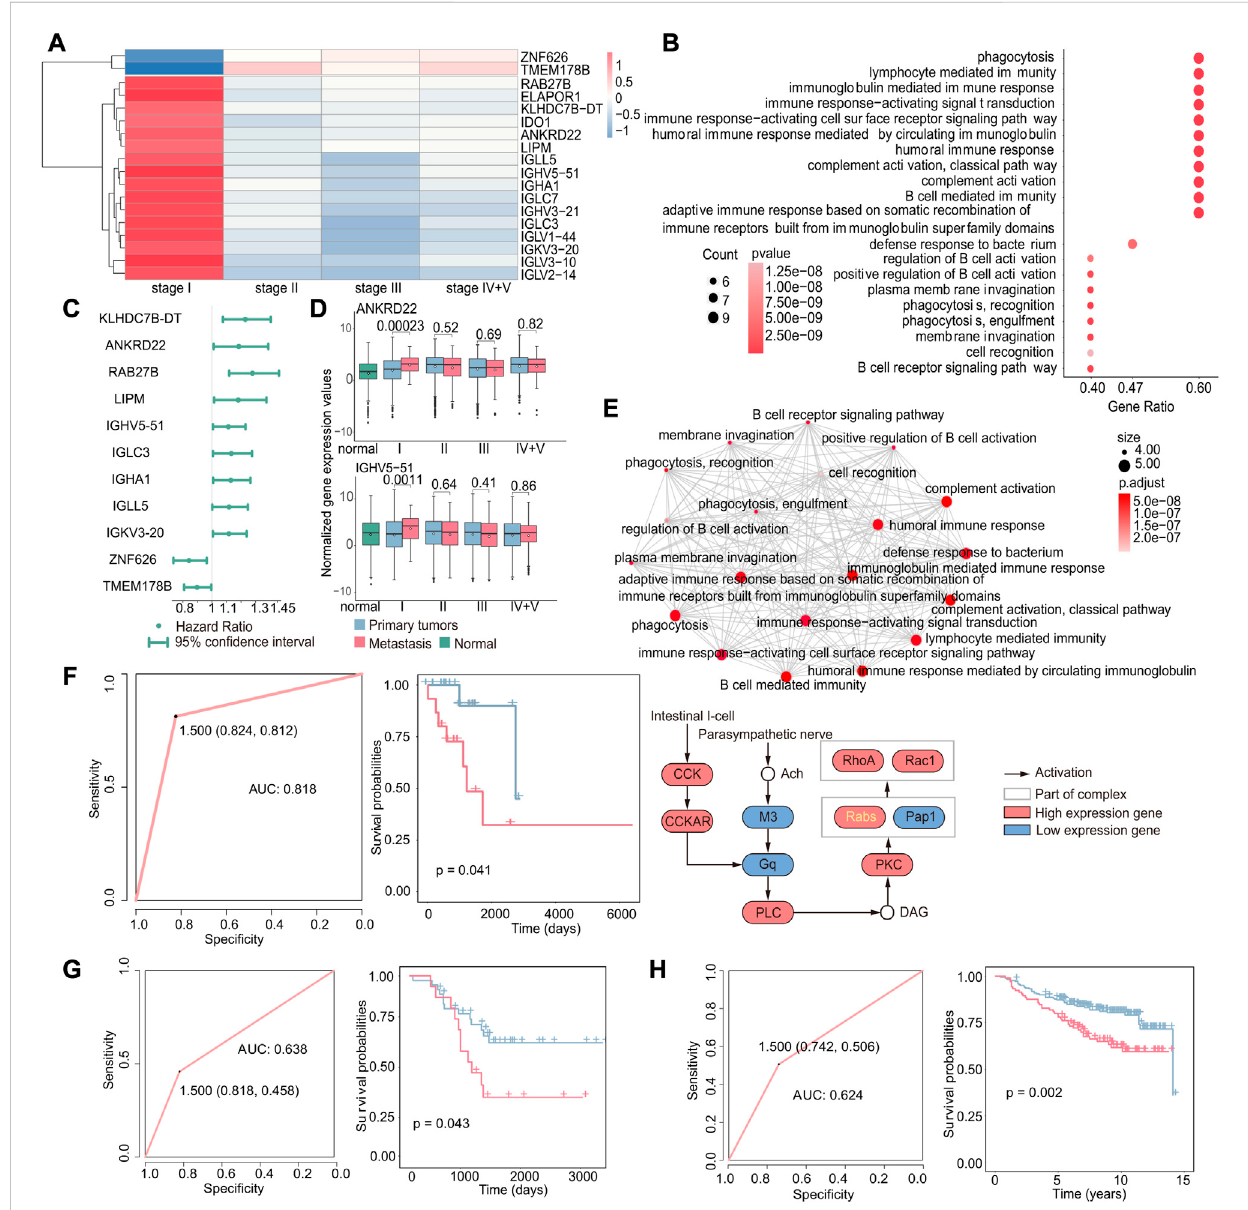
FIGURE 5 Gene expression-based biomarkers related to early metastasis. (A) Heatmap of speci fi c differentially expressed genes in stage I. Red indicates that gene expression was upregulated in metastatic tumors, while blue indicates downregulation. (B) GO enrichment analysis of speci fi c differentially expressed genes in stage I. The size of the dot indicates the number of genes involved in the pathway, and the color of the dot indicates the p -value. (C) Cox regression analysis of stage I-speci fi c differentially expressed genes related to prognosis. The point is the value of the hazard ratio, and a value greater than 1indicates that it wasrelated to poor prognosis. (D) Boxplot oftheexpression ofANKRD22and IGHV5-51 innormal, primary, and metastatic tumor samples. (E) GO enrichmentanalysisof nine genes that wererelated to poor prognosis and speci fi cally differentially expressedin stage I(up). Each dot represents a pathway, and the connecting two points mean that the same genes were in the pathways; KEGG enrichment analysis of the nine genes (down). Speci fi c genes in the KEGG pathway were marked in yellow. (F) Based on these nine genes, the ROC curve of the classi fi er constructed by the supportvectormachinemethodandtheKaplan – Meiersurvivalcurveoftheresultoftheclassi fi er.Redindicatessamplespredictedtodevelopmetastasis, and blue indicates samples predicted to have no metastasis. (G) For the GSE44295 dataset, the ROC curve of the k-nearest neighbor classi fi er and the Kaplan – Meier survival curve of the classi fi cation result. Red indicates samples predicted to develop metastasis, and blue indicates samples predicted to have no metastasis. (H) For the GSE20685 dataset, the ROC curve of the k-nearest neighbor classi fi er and the Kaplan – Meier survival curve of the classi fi cation result. Red indicates samples predicted to develop metastasis and blue indicated samples predicted to have no